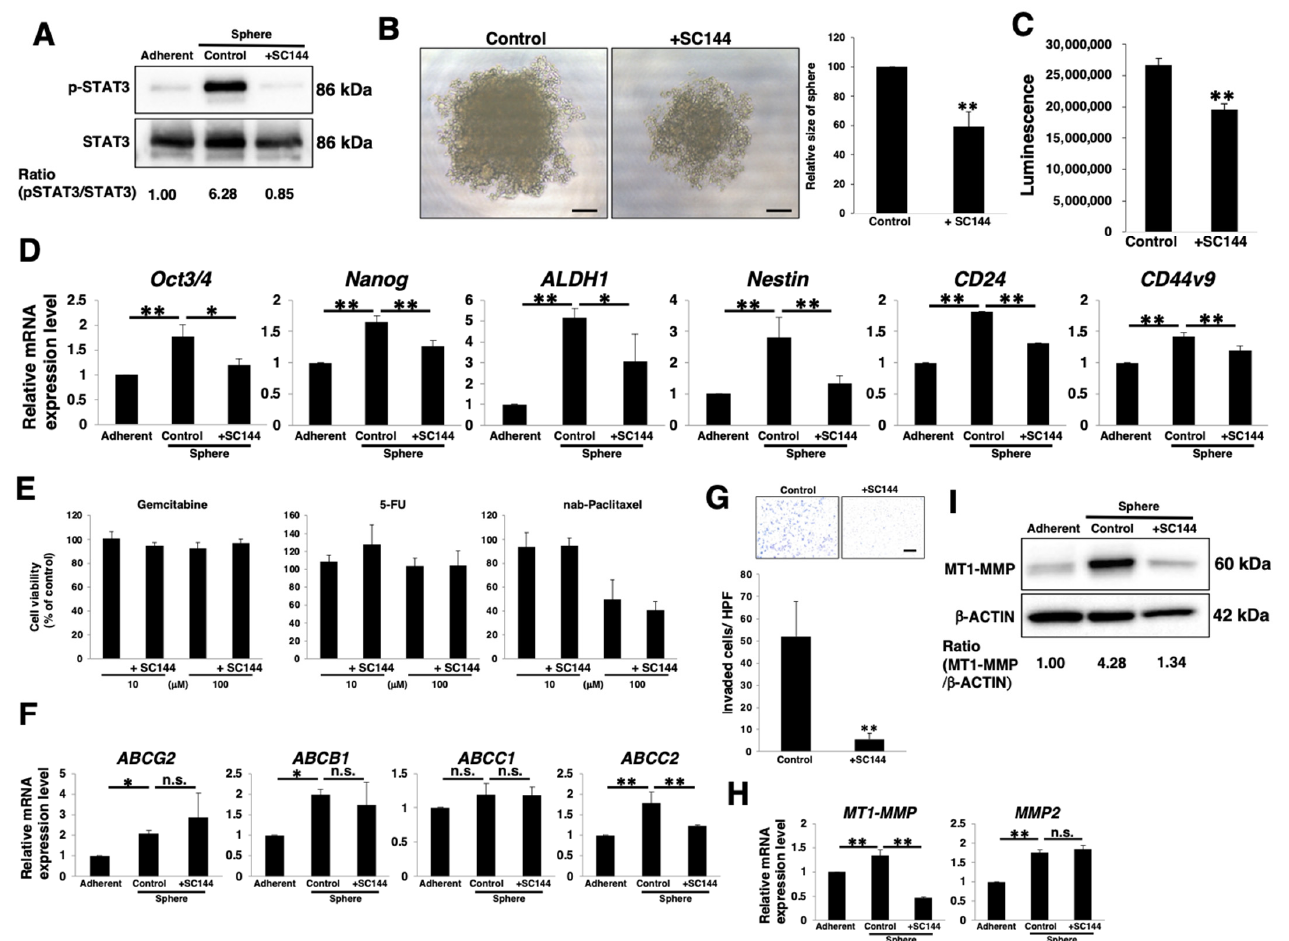
Figure 3. Active gp130/STAT3 pathway involved in stemness and invasion of PANC-1 sphere cells. PANC-1 cells were cultured for 7 days in 2D (adherent) or 3D (sphere) conditions with or without 1 μ M SC144. The cells were harvested for use in the described experiments. In ( E ), as described in Materials and Methods, each anticancer drug was added to 7-day-cultured sphere cells, and the cells were further cultured for 4 days. ( A ) Western blot analysis of p-STAT3 and STAT3. Relative band intensity is presented. ( B ) Phase-contrast image of PANC-1 sphere cells in 96-well ultra-low attachment plates at day 7. The histograms show the relative sizes of spheres (control = 100). Results are presented as means ± SD from four sphere images. Scale bar: 5 μ m. ( C ) ATP assay for growth rate of PANC-1 sphere cells. ( D ) Real-time qPCR analysis of stemness markers. Results are normalized to values obtained for adherent cells (value = 1). Results are presented as means ± SD from three independent experiments. ( E ) Anticancer drugs (gemcitabine, 5-FU, or nab-paclitaxel) resistance assay in PANC-1 sphere cells. The dose-response (10 or 100 μ M) of PANC-1 sphere cells to each drug was determined using the ATP assay. ( F ) Real-time qPCR analysis of transporters. Results are normalized to values obtained for adherent cells (value = 1). Results are presented as means ± SD from three independent experiments. ( G ) Matrigel invasion assays were performed in PANC-1 sphere cells. Representative results from measurements of 12 fields are presented. Scale bar: 100 μ m. ( H ) Real-time qPCR analysis of MT1-MMP and MMP2 . Results are normalized to values obtained for adherent cells (value = 1). Results are presented as means ± SD from three independent experiments. ( I ) Western blot analysis of MT1-MMP and β -ACTIN. Relative band intensity is presented. * p < 0.05; ** p < 0.01, n.s.: not significant.